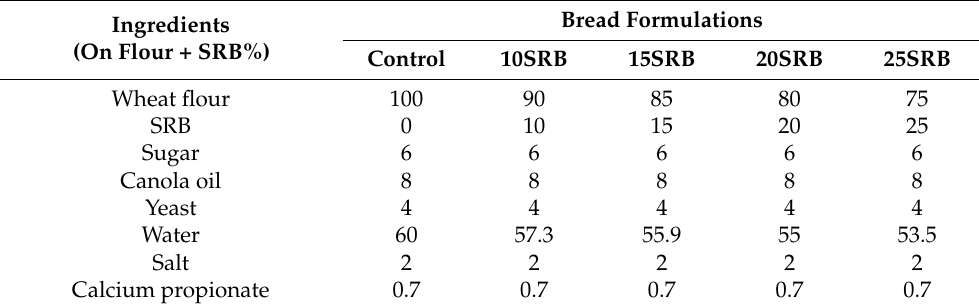
Table 1. Formulations for control and SRB-enriched breads (wheat flour + SRB =